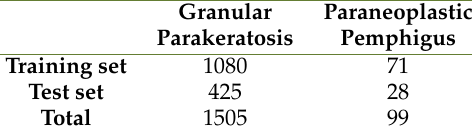
Table 2. A detailed